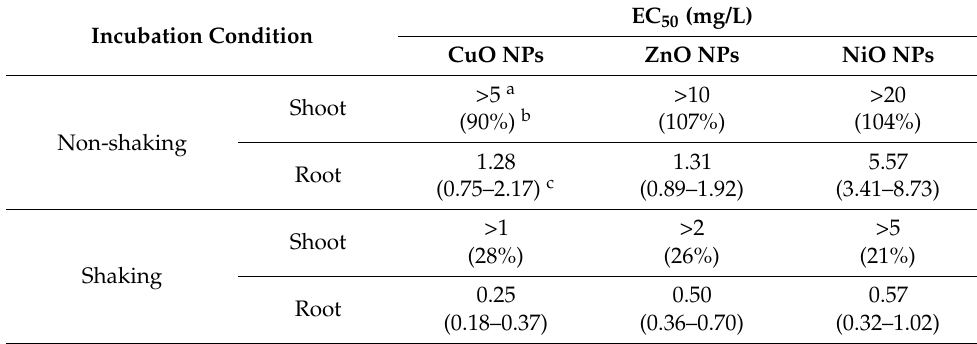
Figure 1. Effects of nanoparticle (NP) exposure on relative shoot growth (RSL) under ( a ) non-shaking and ( b ) shaking conditions. Table 1. Inhibitory effects nanoparticle (NP) exposure on the root and shoot growth of Lactuca sativa under non-shaking and shaking incubation conditions.